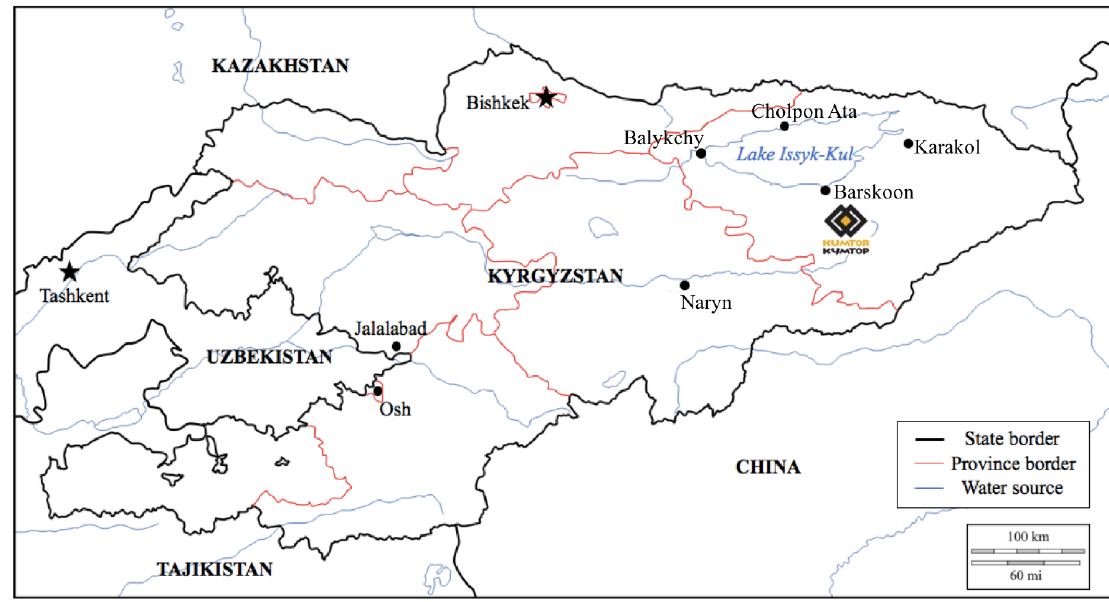
Figure 1. Map of Kyrgyzstan with Kumtor mine.